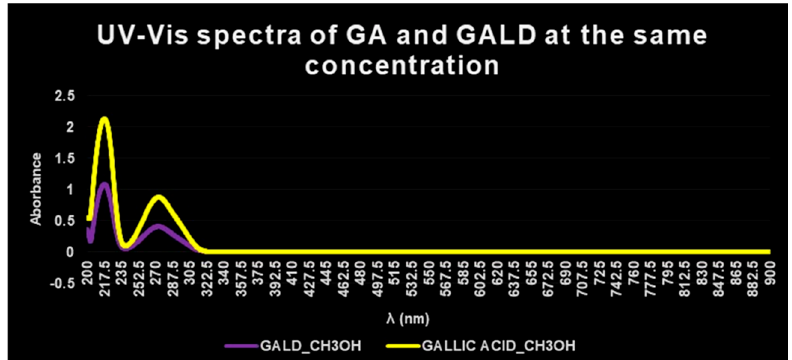
Figure 6. UV–Vis spectra of GALD 7 (violet plot) and GA (yellow plot) in methanol solution and equal concentrations.